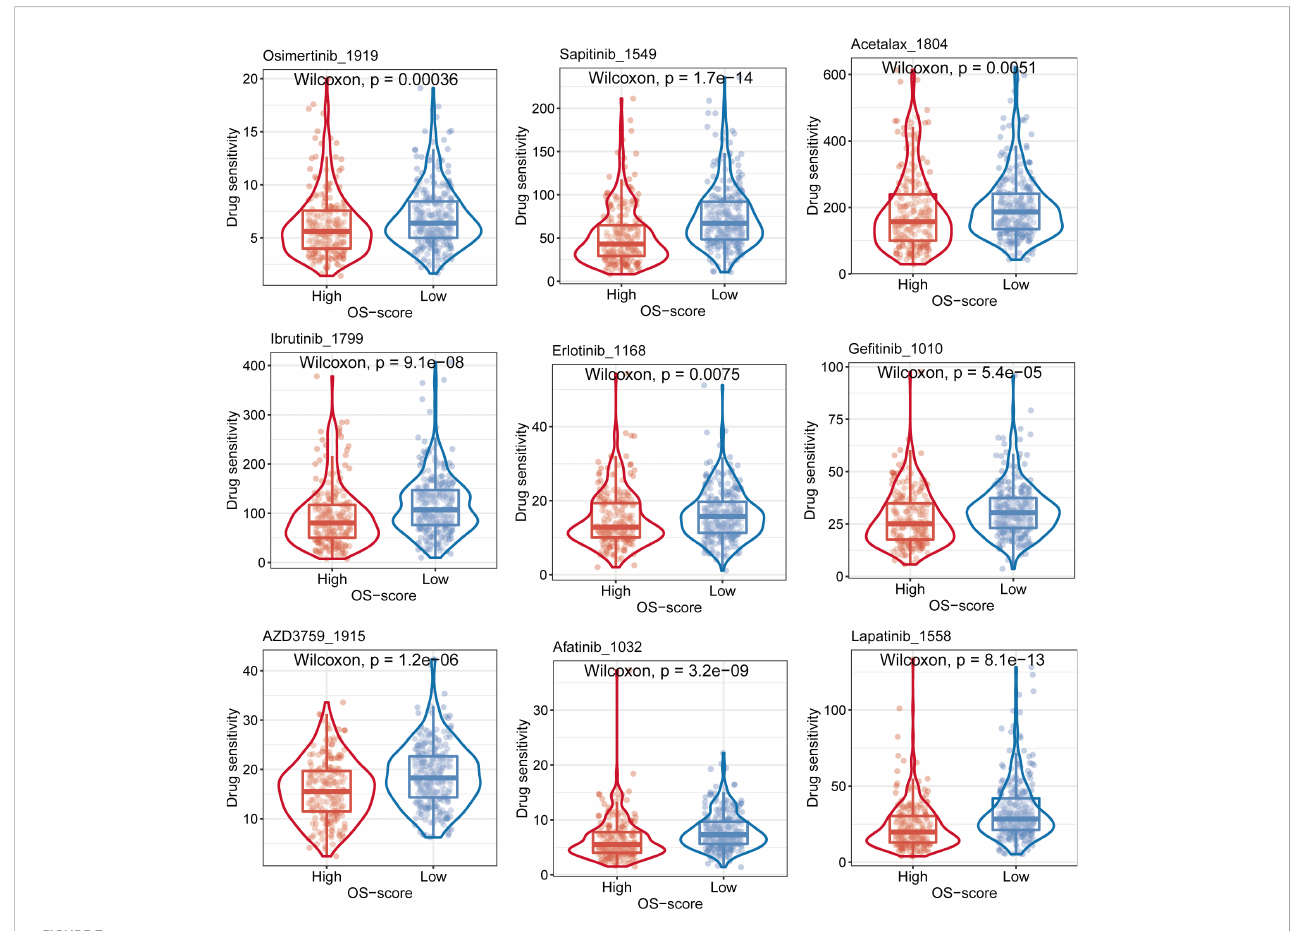
FIGURE 7 Evaluation of sensitivity to chemotherapy for